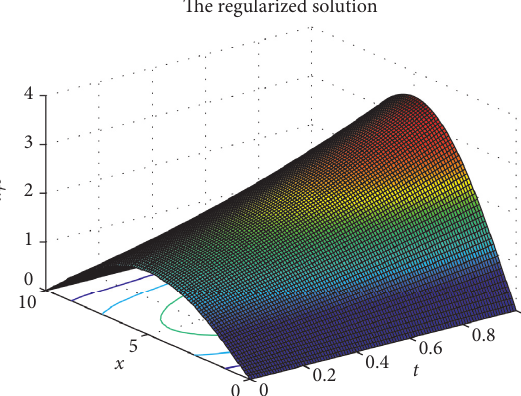
Figure 1: The solution u .